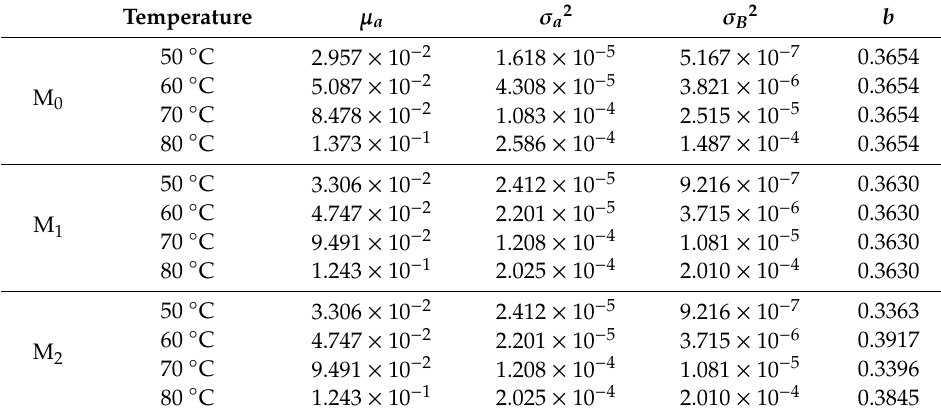
Table 10. Distribution parameters of lifetime under each accelerated stress based on three methods for O-type rubber seal